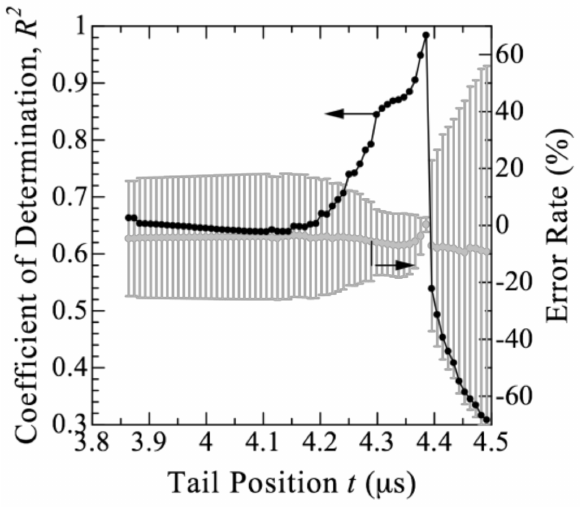
Figure 8. R 2 value and error rate of the estimated field distribution obtained by IRs optimized for various tail positions. The error bar represents the standard deviation of the error rate along the insulation thickness.